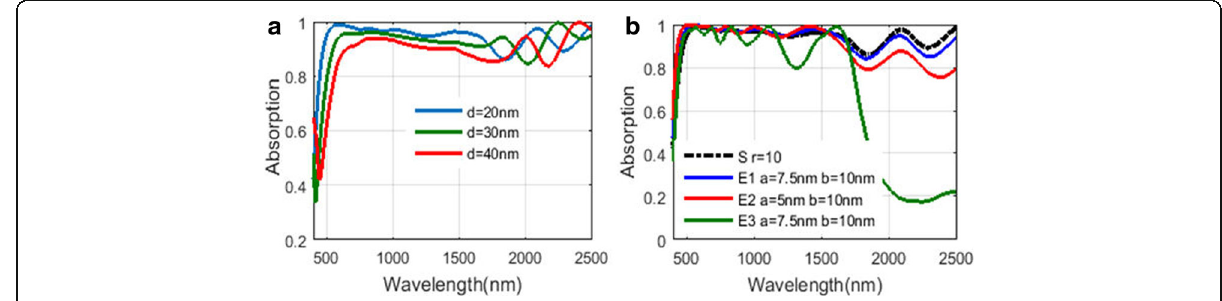
Fig. 14 a Absorbing spectrum of the NPA structure varying with nanoparticle size. b Absorbing spectrum of the NPA structure for nanoparticles with different shapes. S sphere, E ellipsoid, a the major axis semidiameter of the ellipsoid, b is the minor axis semidiameter of the ellipsoid. For E1 and E2, the electric filed is along the major-axis direction. For E3, the electric field is along the minor-axis